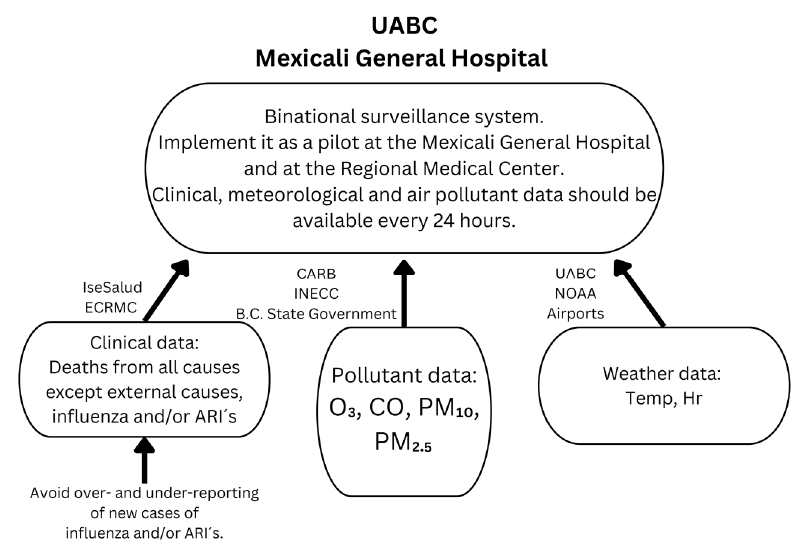
Figure 2. Main actors in getting data to the pilot station: (1) Clinical data: Secretariat of Health (IseSalud), El Centro Regional Medical Center. (2) Pollutant data: California Air Resources Board (CARB), National Institute of Ecology and Climate Change (INECC), Baja California State Government. (3) Meteorological data: Engineering Institute of the UABC, Mexicali B.C. and Imperial Valley Airports, National Oceanic and Atmospheric Administration (NOAA).